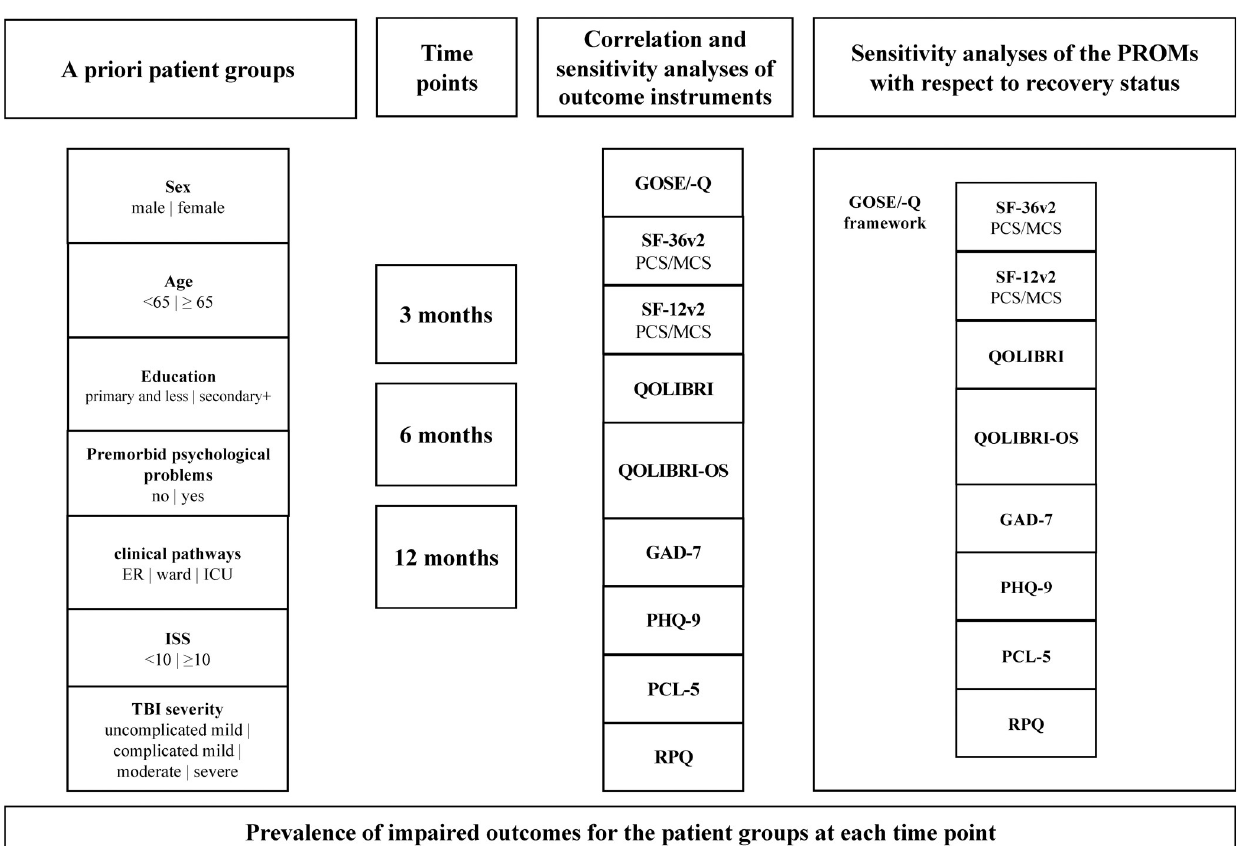
Fig 1. Overview of sensitivity analyses. ER = emergency room; ICU = intensive care unit; ISS = Injury Severity Scale; GOSE/-Q = Combined information on recovery status using the Glasgow Outcome Scale–Extended and its questionnaire version; SF-36v2 = 36-item Short Form Health Survey–version 2; SF- 12v2 = 12-Item Short Form Survey–version 2; PCS = Physical Component Summary Score, MCS = Mental Component Summary Score; QOLIBRI = Quality of Life after Traumatic Brain Injury; QOLIBRI-OS = Quality of Life after Traumatic Brain Injury–Overall Scale; GAD-7 = Generalized Anxiety Disorder-7; PHQ-9 = Patient Health Questionnaire-9; PCL-5 = Posttraumatic Stress Disorder Checklist for DSM-5; RPQ = Rivermead Post- Concussion Symptoms